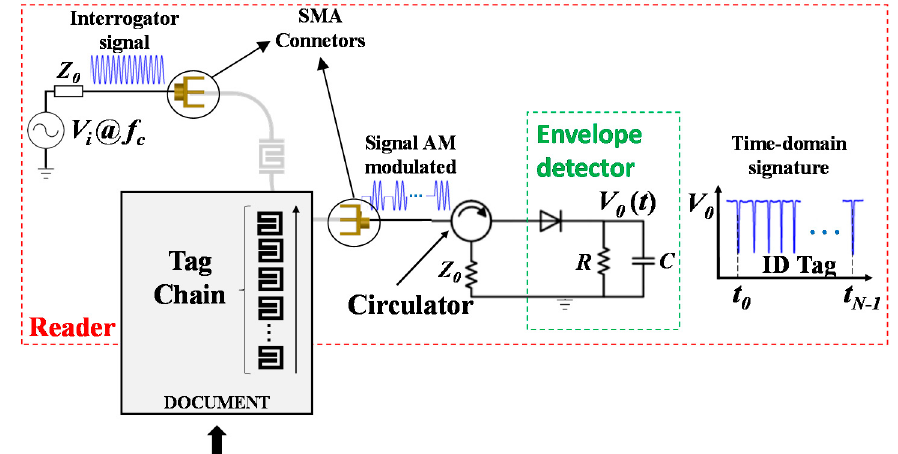
Figure 1. Sketch of the operating principle of the time-domain chipless-RFID system implemented on the basis of near-field and sequential bit reading.